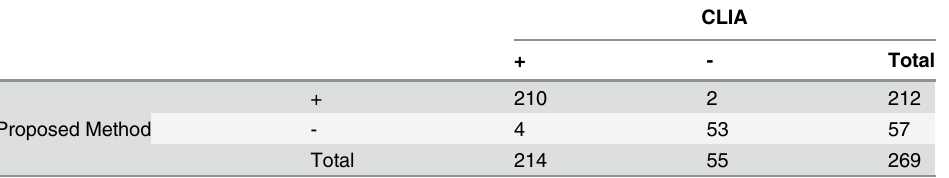
Table 6. McNemar ’ s test between the proposed method and CLIA for the test of 269 anti- HBs